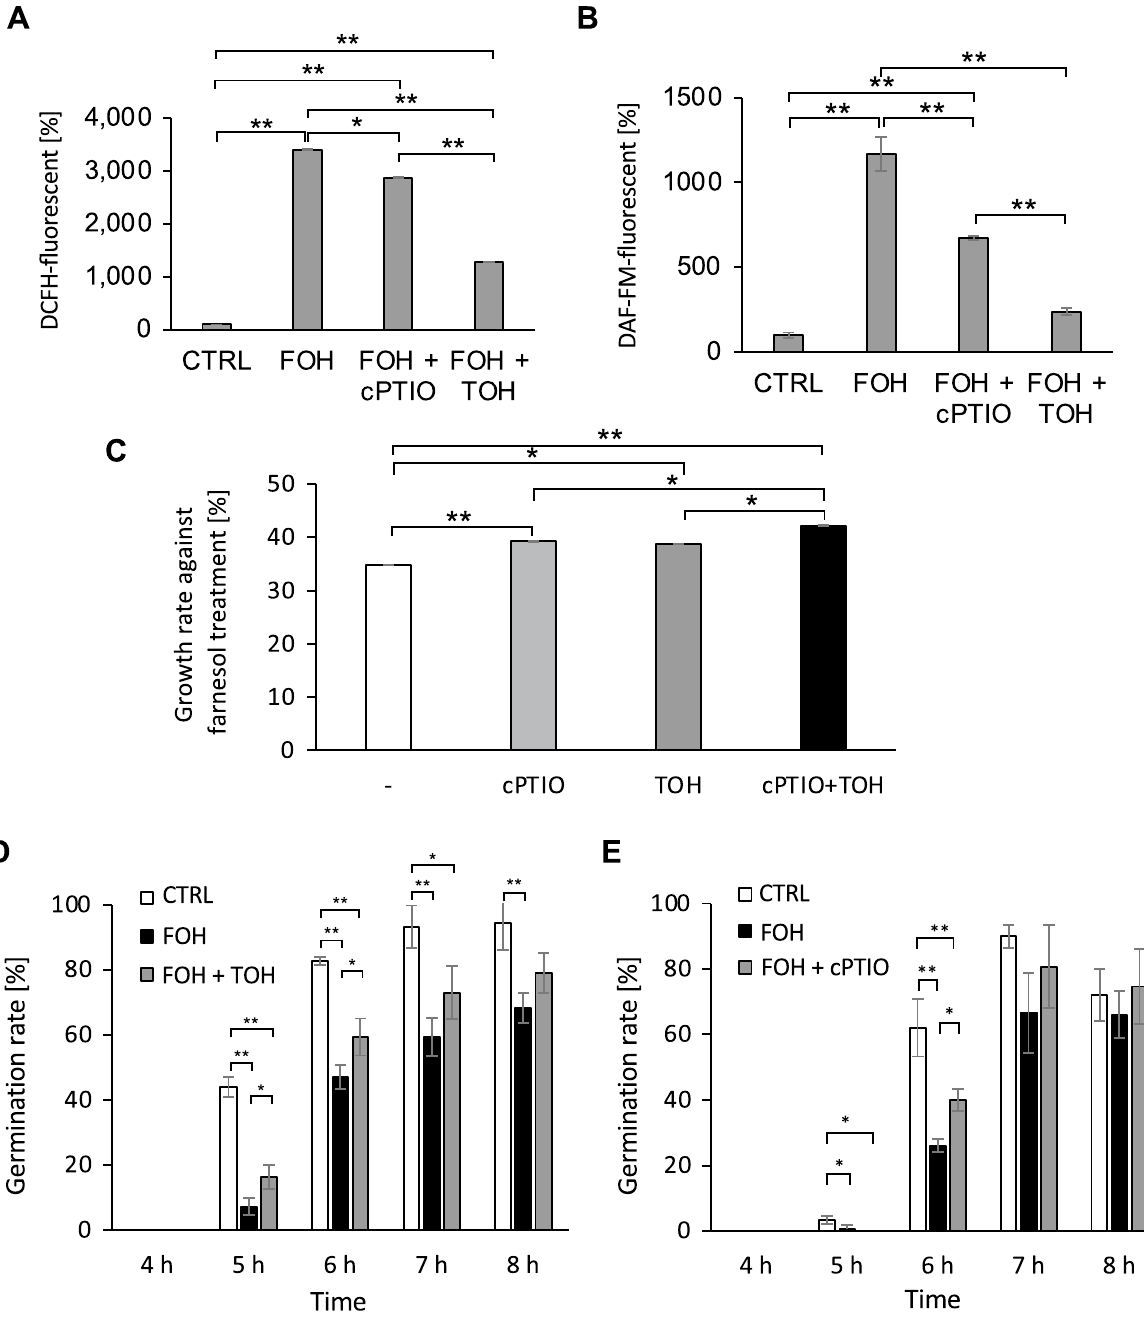
Figure 4. The effects of ROS and NO scavengers. ( A ) The DCFH-related fluorescence intensity after treatment with farnesol was measured with or without cPTIO and tocopherol (TOH). ( B ) The DAF-FM-related fluorescence intensity after treatment with farnesol was measured with or without cPTIO and TOH. The data were obtained from three biological replicates, and the error bar represents the standard deviation. ( C ) The effects of the scavenger compounds on farnesol-induced growth inhibition were evaluated. ( D ) The effects of TOH on germination kinetics in the presence of farnesol. ( E ) The effects of cPTIO on germination kinetics in the presence of farnesol. The data were obtained from three biological replicates, and the error bar represents the standard deviation. Significant difference between samples were examined using Tukey’s tests and are indicated as * p < 0.05; ** p <